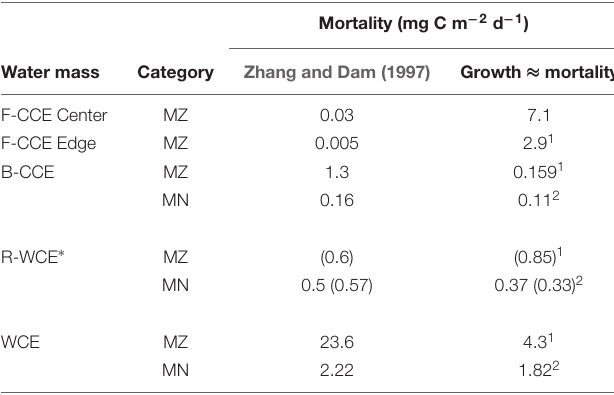
TABLE 5 | Comparison of two different approaches to estimate mortality of mesozooplankton and micronekton: (1) Zhang and Dam (1997) isometric approach based on Peterson and Wroblewski (1984), and (2) assuming the system is under steady-state and mortality is approximately equivalent to growth, various growth rate equations have been